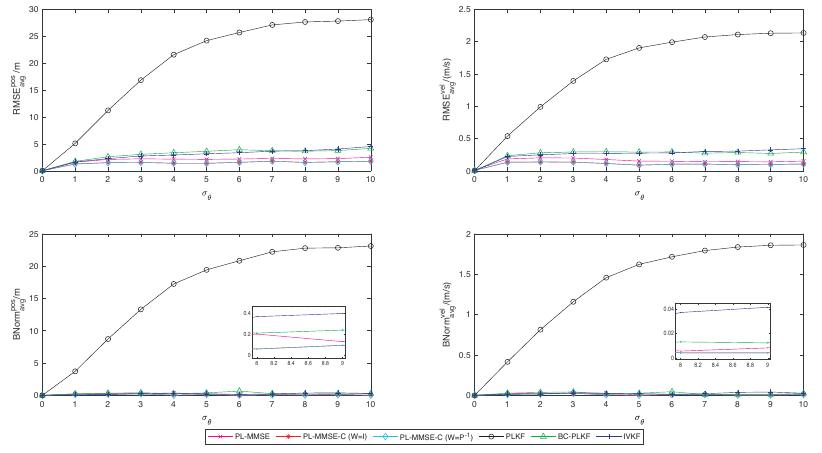
Figure 4. Time-averaged RMSEs, BNorms and bearing noise standard deviation for the PL-MMSE, PLKF, BC-PLKF and IVKF algorithms, as well as, the PL-MMSE algorithm with linear constraints proposed in the paper.